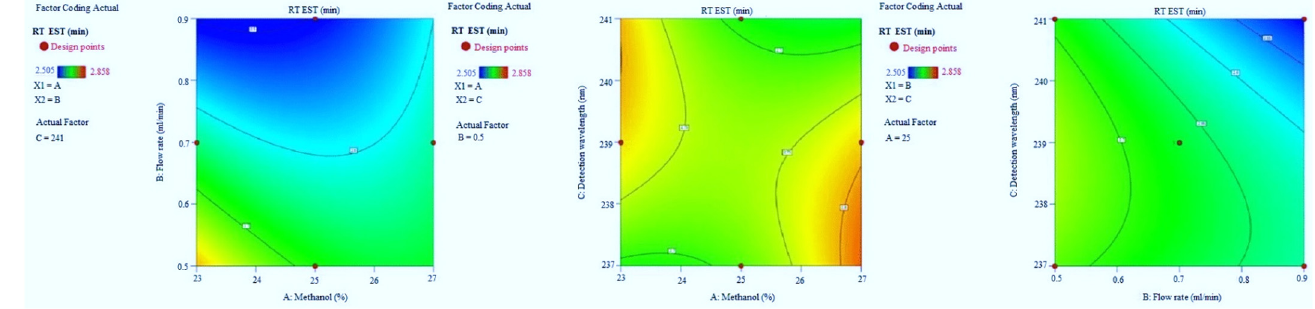
Figure 2. Contour plots for escitalopram (EST) retention time in terms of AB, AC, and BC.